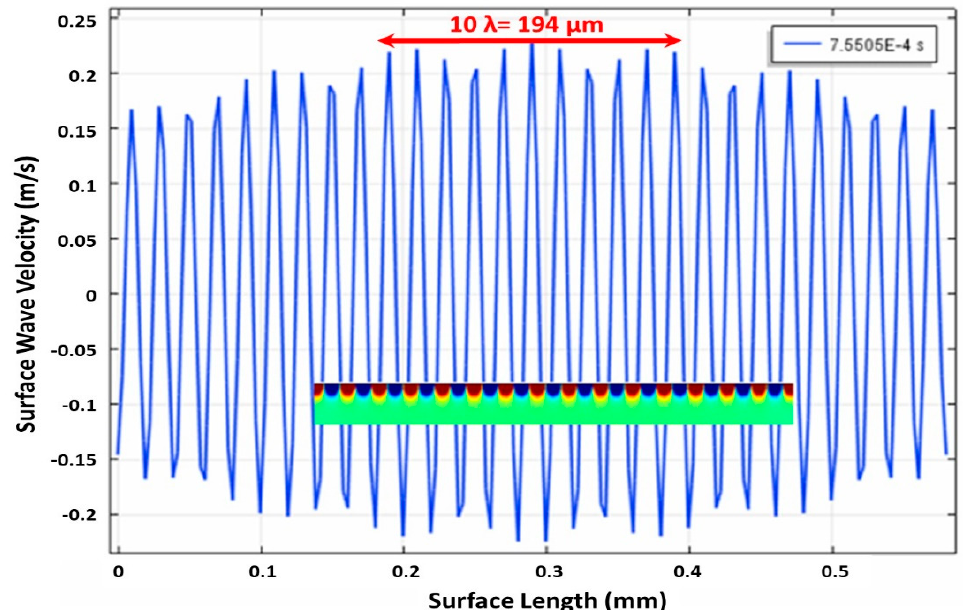
Figure 4. The vibrational velocity is propagated throughout the water surface on the tip of the sili- con-based three-horn in the modeling. Inset: the 2D velocity profile at the corresponding position at 7.5505 × 10 − 4 s simulation time. The red and blue colors present the displacement in the opposite directions.